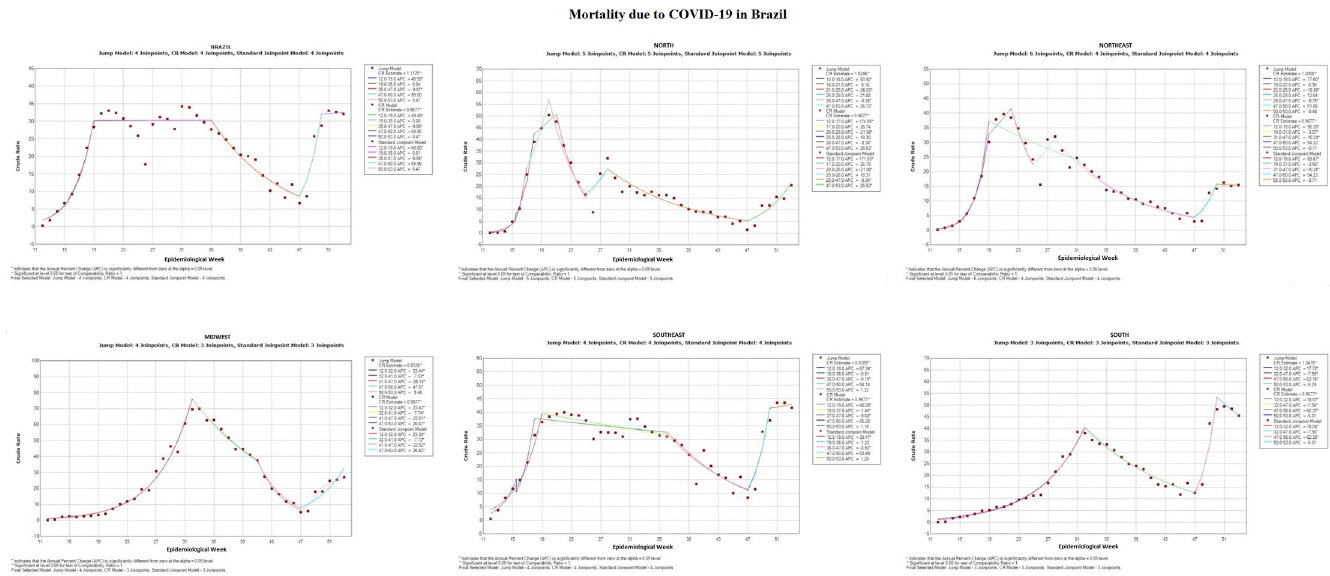
Fig 1. Mortality rate due to COVID-19 in Brazil and regions in the period from 12ª to 53ª epidemiological week. Brazil, 2020.